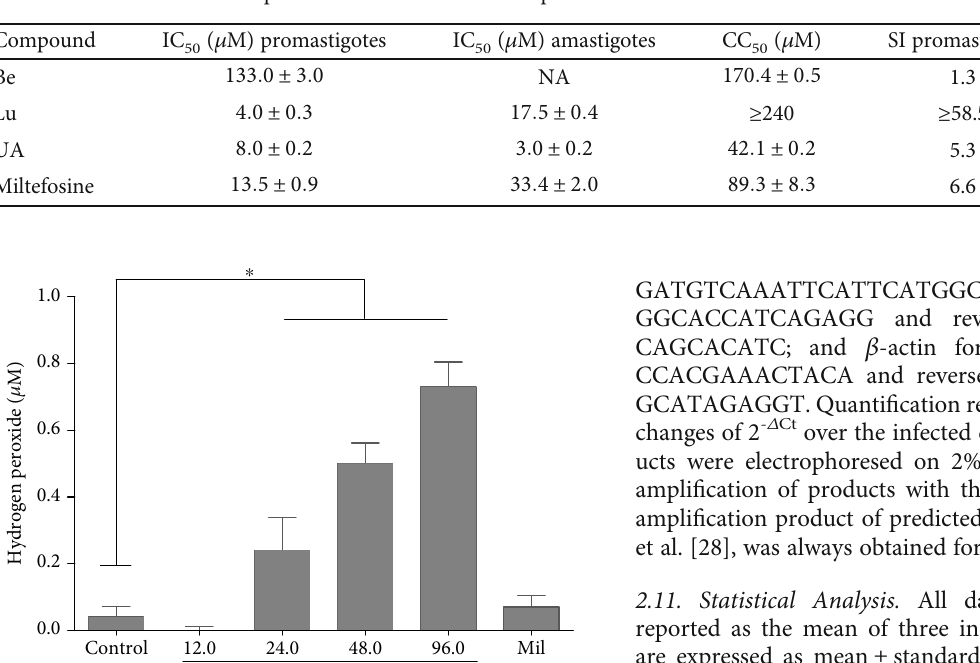
Table 1: Leishmanicidal and cytotoxic activity and selective index of betulin (Be), lupeol (Lu), and ursolic acid (UA). Results are expressed by mean and standard error of triplicates from three di ff erent experiments.